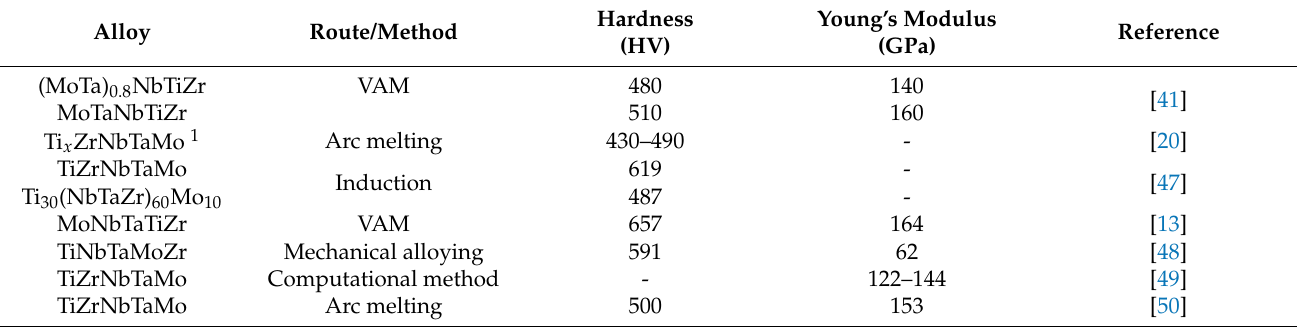
Table 4. Mechanical properties of dual BCC